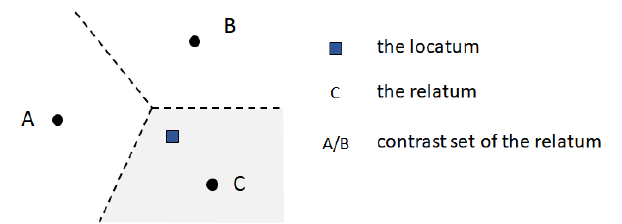
Figure 10. The search space of a qualitative distance relationship with contrast set information, represented by the shaded